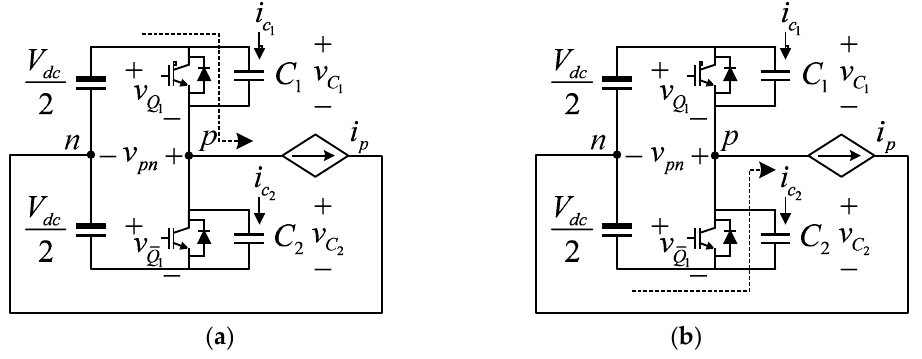
(cid:16) (cid:17) i p > 0 ; ( a ) the upper switch is